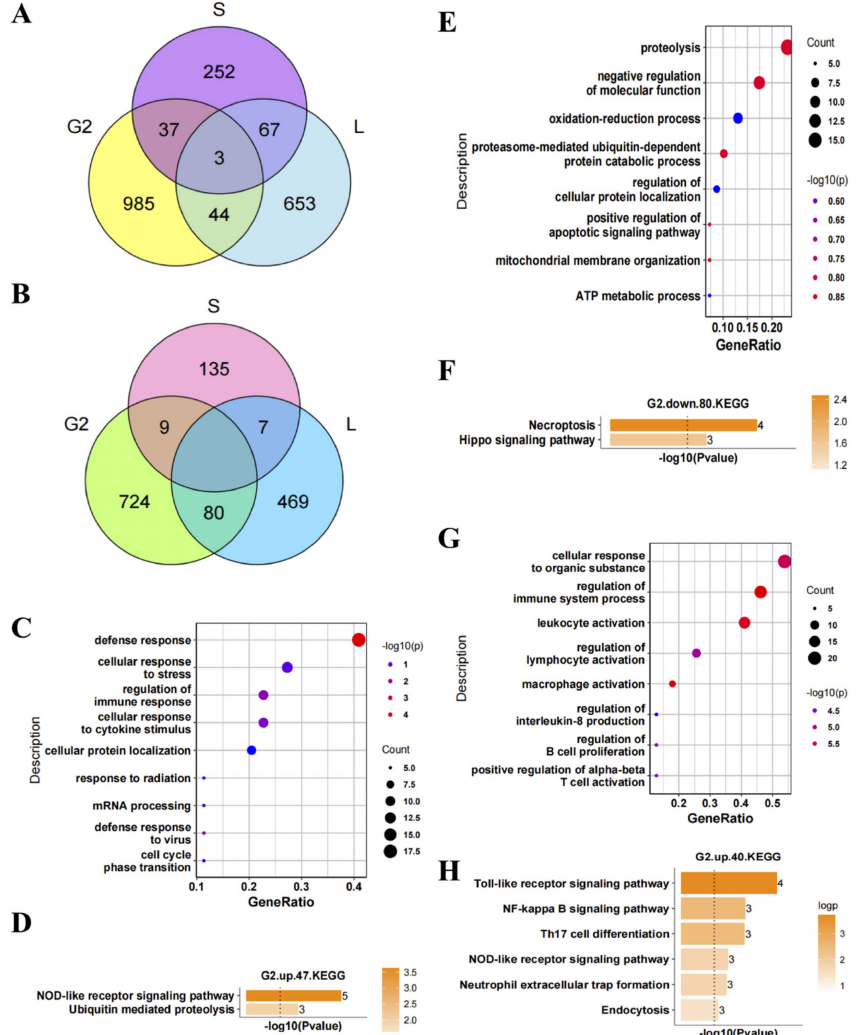
Figure 5. Identification of differentially expressed genes (DEGs) co-existing in the nerve tissue, lymphoid tissue, and whole blood of amyotrophic lateral sclerosis (ALS) patients and their functional enrichment analysis. ( A ) Venn diagram of the up-regulated genes in the nerve tissue, lymphoid tissue, and whole blood (G2: DEGs in nerve tissue of ALS patients (sel.2g), L: DEGs in lymphoid tissue of ALS patients, S: DEGs in whole blood of ALS patients). ( B ) Venn diagram of the down-regulated genes in the nerve tissue, lymphoid tissue, and whole blood of ALS patients. Gene Ontology (GO) biological process analysis and Kyoto Encyclopedia of Genes and Genomes (KEGG) analysis of the ( C , D ) up- and ( E , F ) down-regulated genes co-existing in the nerve tissue and lymphoid tissue of ALS patients and the ( G , H ) up-regulated genes co-existing in the nerve tissue and whole blood of ALS